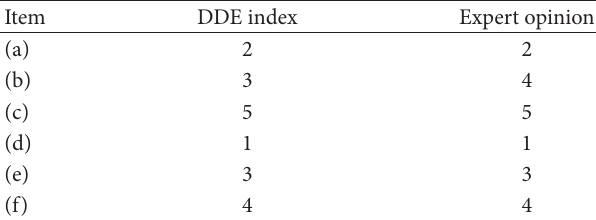
Table 6: The comparisons between the DDE index and the subjec- tive evaluation results of calamity rescue